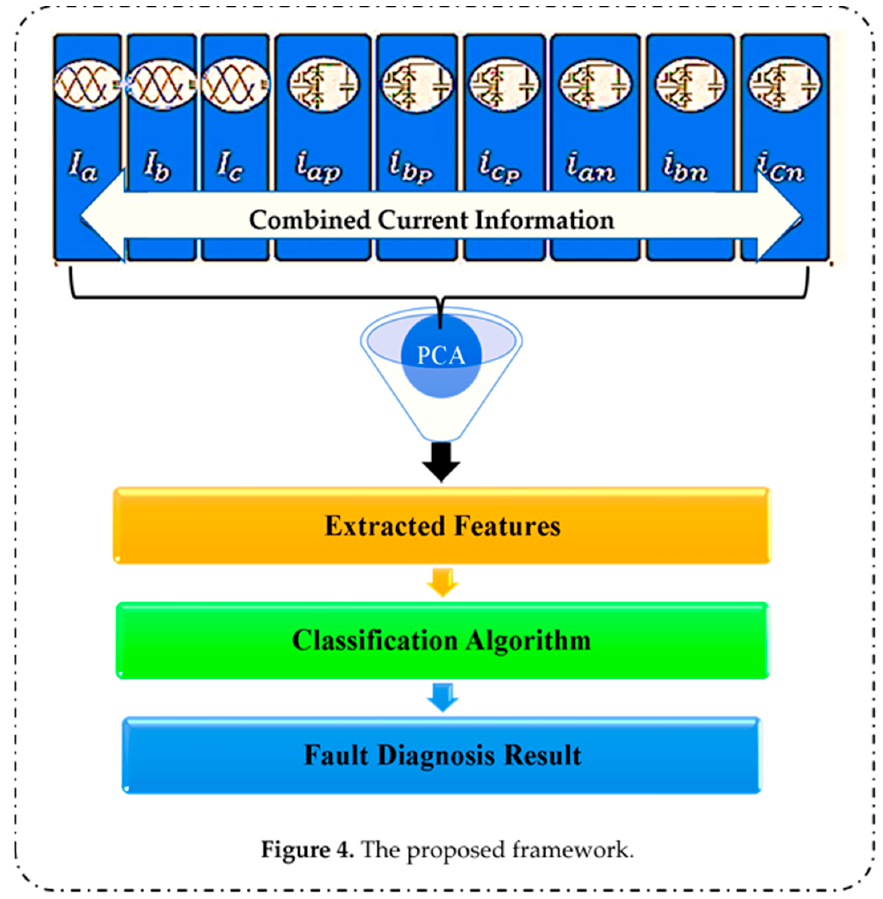
Figure 4. The proposed